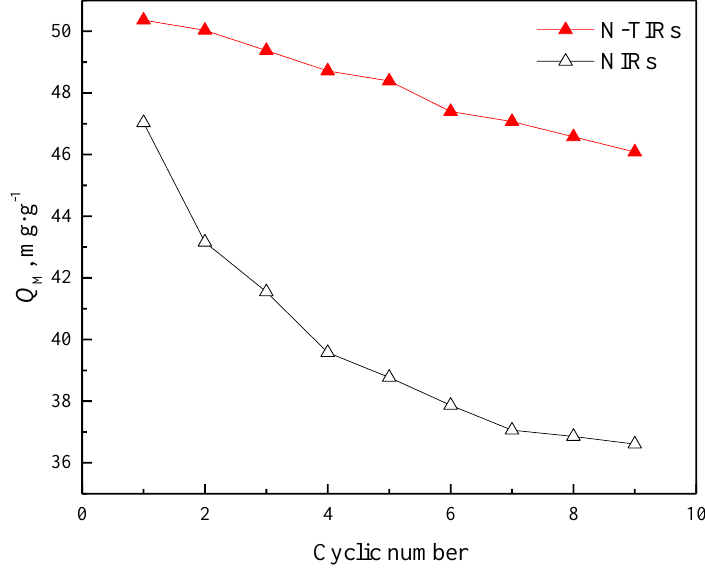
Figure 12. Stability of the N-TIRs and NIRs during cyclic use.